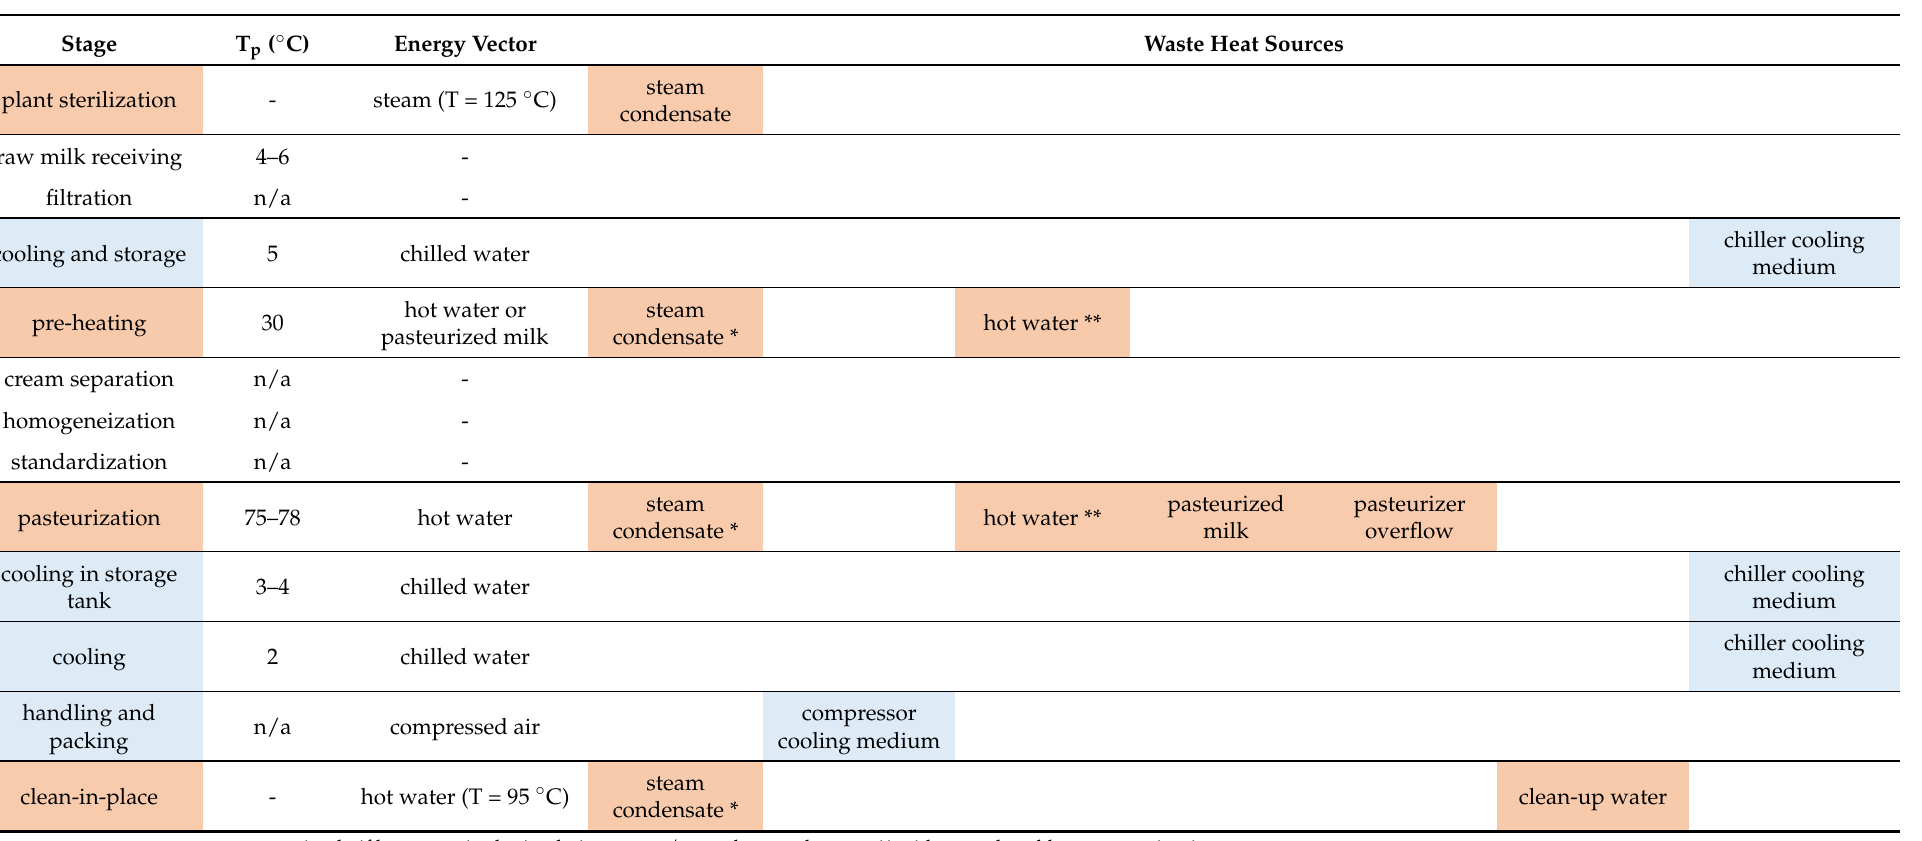
Table 5. Scheme of pasteurized milk manufacturing process and low-temperature waste heat sources after validation and contextualization via the analysis of energy